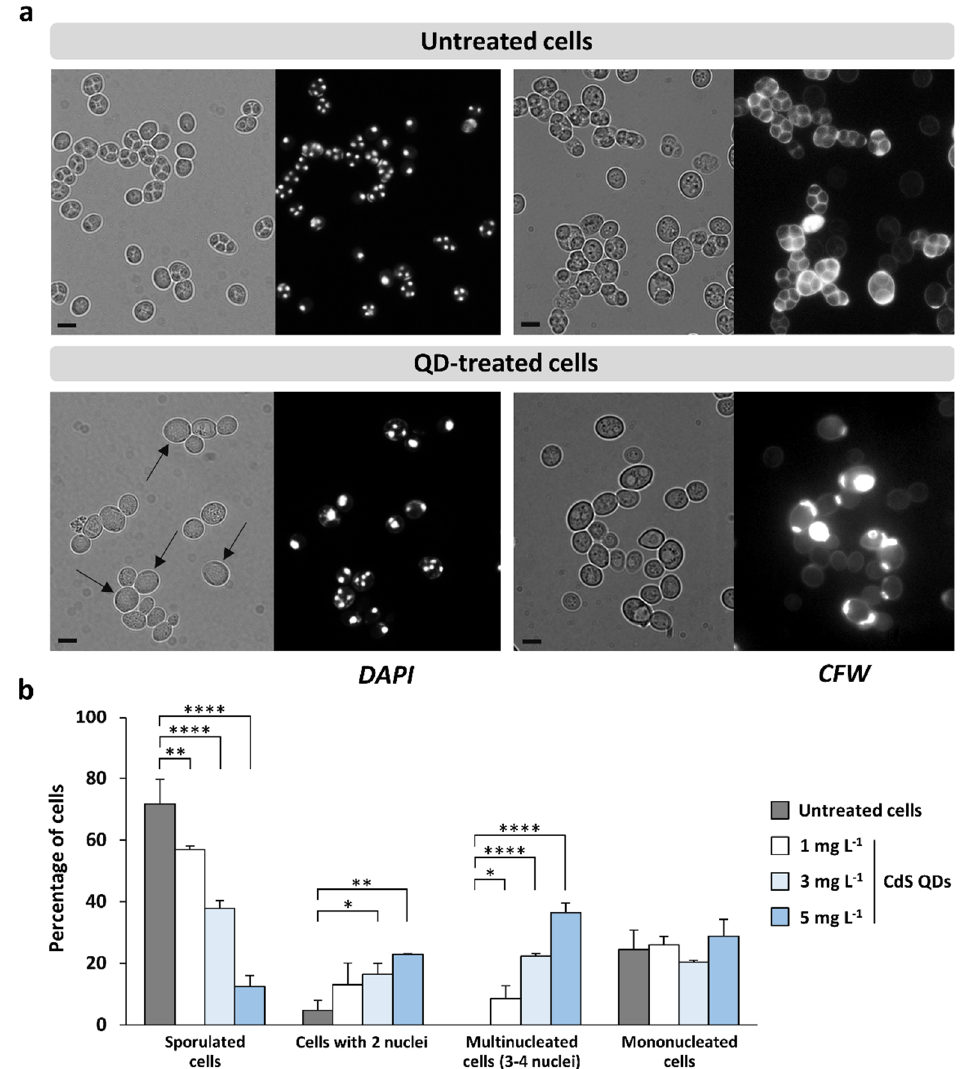
Figure 3. CdS QDs strongly affect the sporulation process. ( a ) Z239-6B-6B diploid strain was grown in sporulation conditions in the presence (or not) of CdS QD treatment (1–5 mg L − 1 ); after 72 h, cells were then stained with DAPI and calcofluor white (CFW) and analyzed using fluorescence microscopy. CdS QD treatment caused the formation of asci containing three or four nuclei but with the absence of refractile spores (multinucleated cells, indicated by black arrows). Representative images (scale bars, 5 μ m) of untreated and CdS QD-treated (5 mg L − 1 ) cells are shown. ( b ) The percentage of cells (relative to the total number of cells stained with DAPI) representative of each phenotypic category was quantified. The values shown in the histograms are the mean (±standard deviation) of three independent experiments performed in triplicate. Significance was determined by one-way ANOVA with Dunnett’s multiple comparisons test. * p < 0.05; ** p < 0.01; **** p < 0.0001.